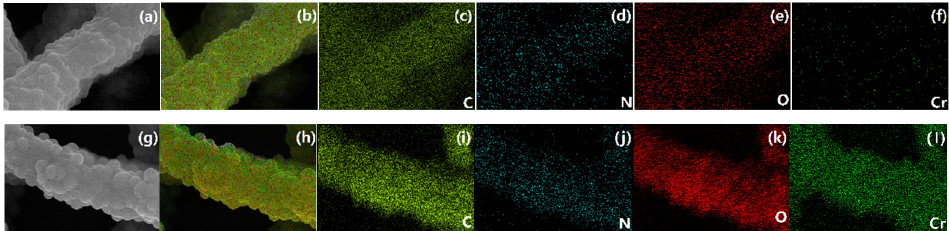
Figure 8. SEM and EDS images of PAN/APNs ( a – f ) and PAN/APNs-Cr ( g – l ): SEM ( a,g ), overlapped EDS image ( b,h ), carbon ( c,i ), nitrogen ( d,j ), oxygen ( e,k ) and chromium ( f,l ).